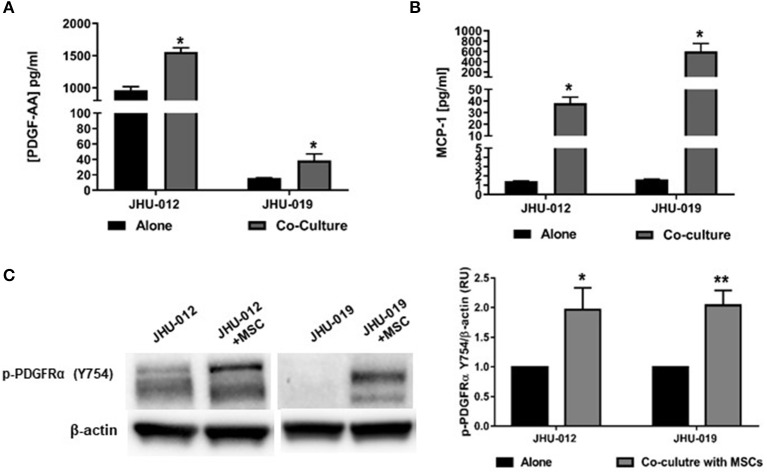
MSCs induce increased production of PDGF-AA and MCP-1 and Autocrine Activation of PDGFR-α in OSCC. JHU-012, and −019 were grown alone or in 1:1 co-culture with MSCs for 6 days and production of PDGF-AA and MCP-1 measured using a multiplex assay approach and activation of PDGFR-α determined by Western immunoblotting. There was a significant increase in the production of PDGFAA (A) and MCP-1 (B) in the conditioned media from cancer cells grown in co-cultured compared to cancer cells grown alone (n = 3, p < 0.005). (C) Following co-culture with MSCs, there was a significant increase in expression of p-PDGFR-α (Y754) in JHU-012 and −019 co-cultures (n = 3; *p < 0.02; **p < 0.006).